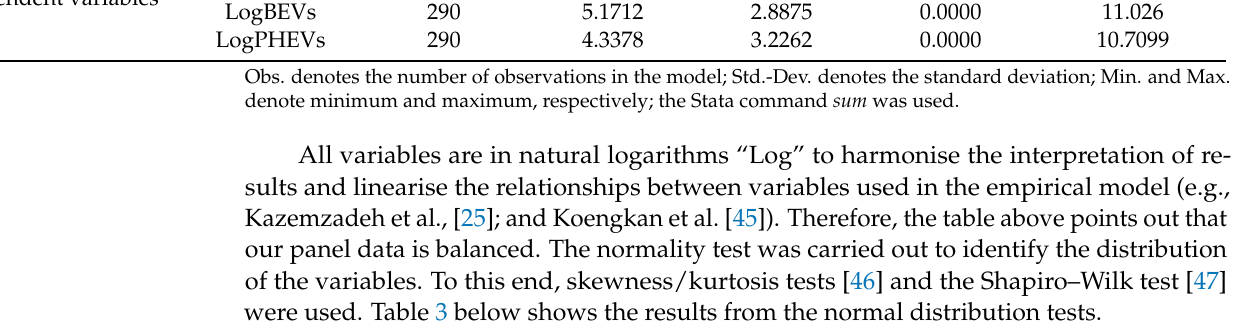
Table 3. Skewness/kurtosis and Shapiro–Wilk